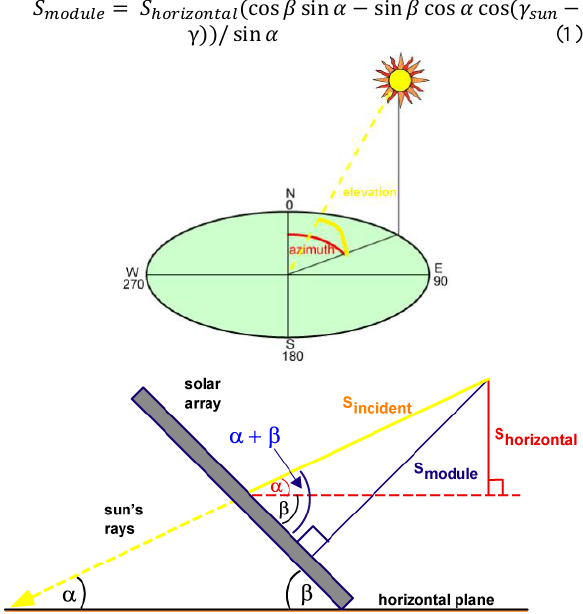
Figure 1: Sun’s Position and module’s orientation (Honsberg & Bowden, 2013)